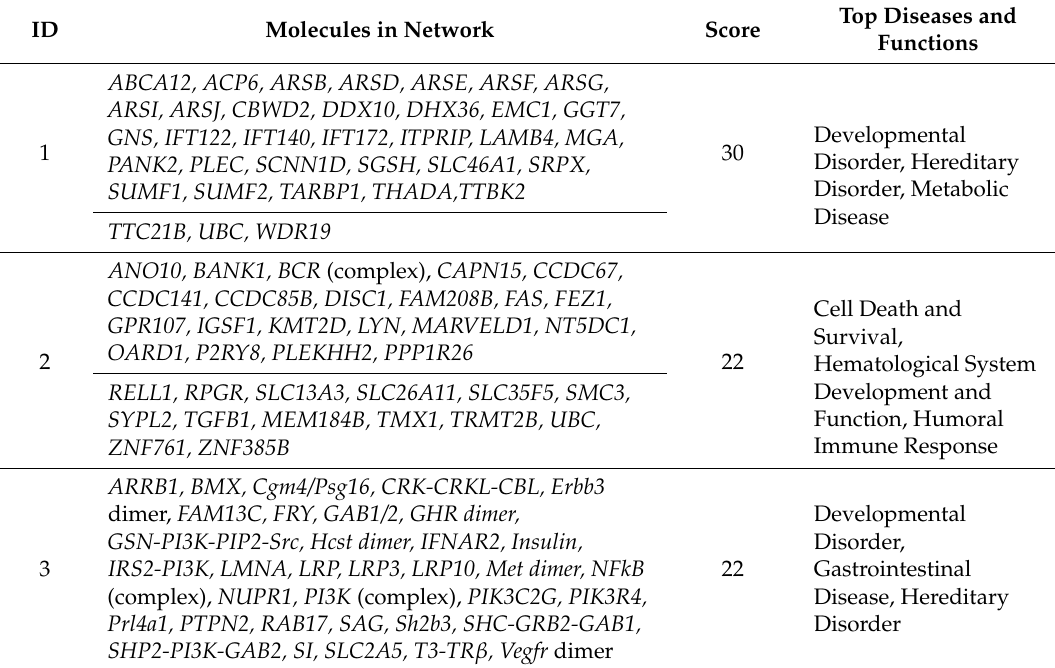
Table 6. Associated network functions of candidate